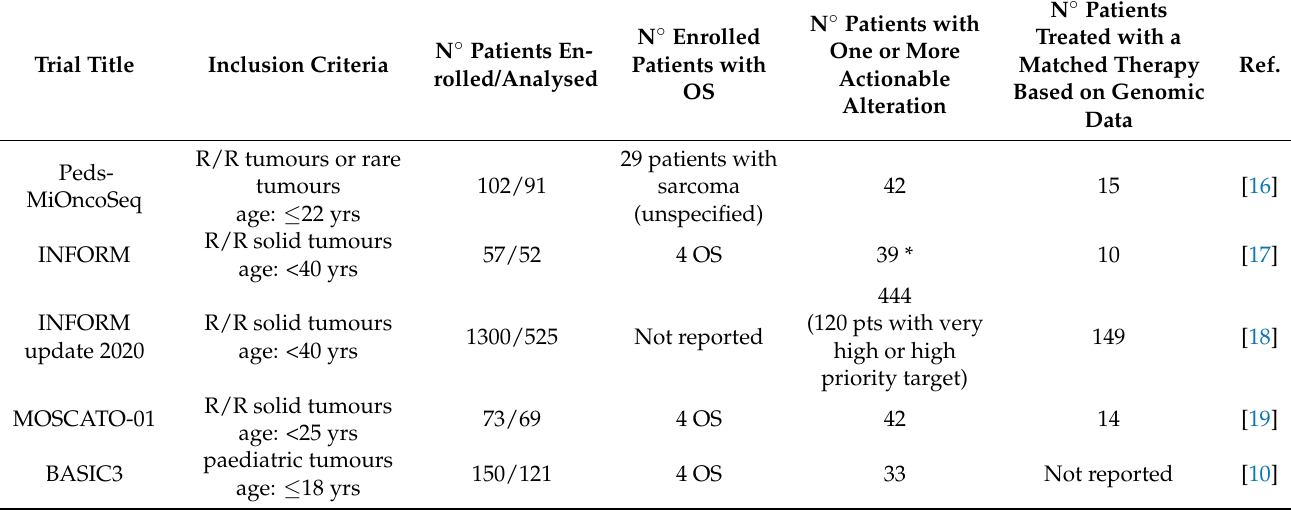
Table 1. Published data of recent genomic programs including patients with